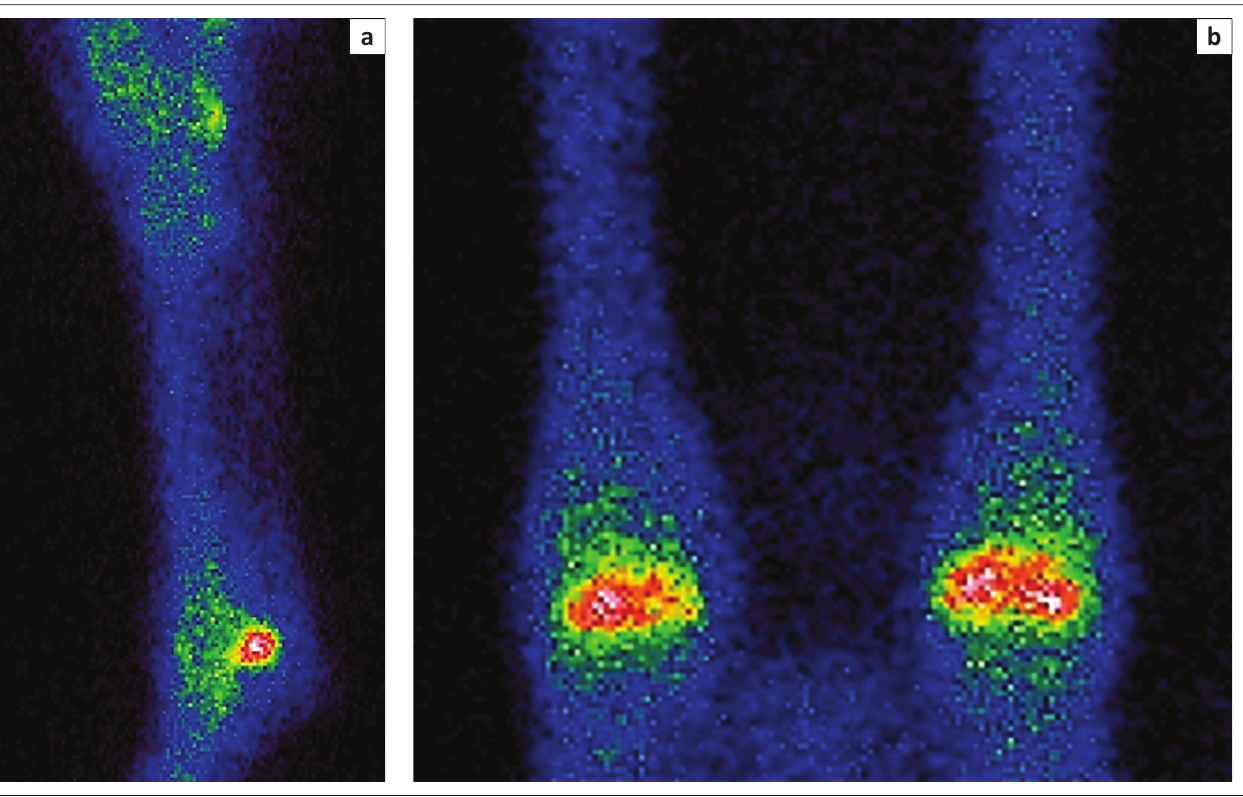
FIGURE 5: (a) Lateral left distal hindlimb and (b) plantar bilateral distal hindlimb scintigraphy images acquired in the bone phase of a 6-year-old Friesian stallion (same horse as in Figures 2 and